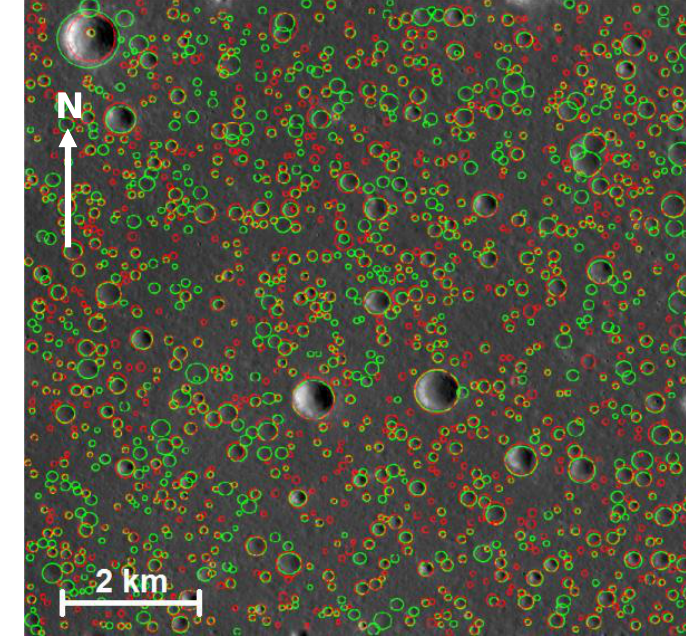
Figure 4. Part of the calibration area. Manually counted craters are indicated by green circles, CDA detection results by red circles. Image data: Kaguya TC (Haruyama et al., 2014).